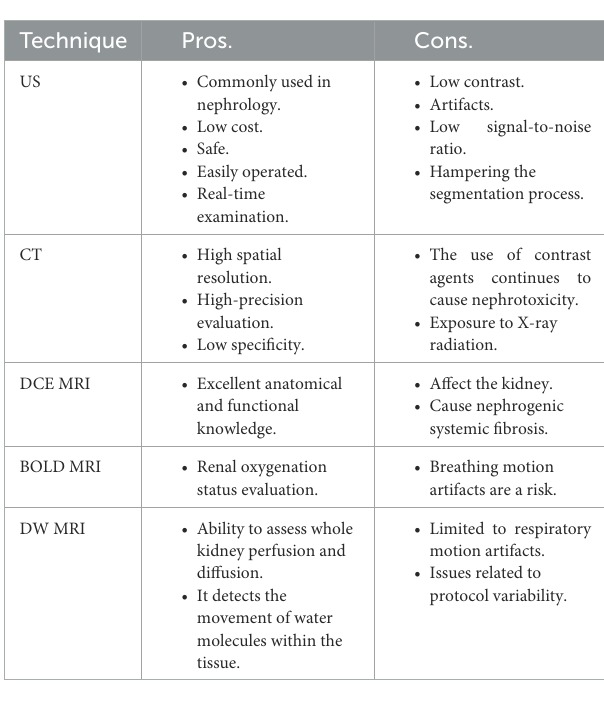
TABLE 1 Common renal imaging